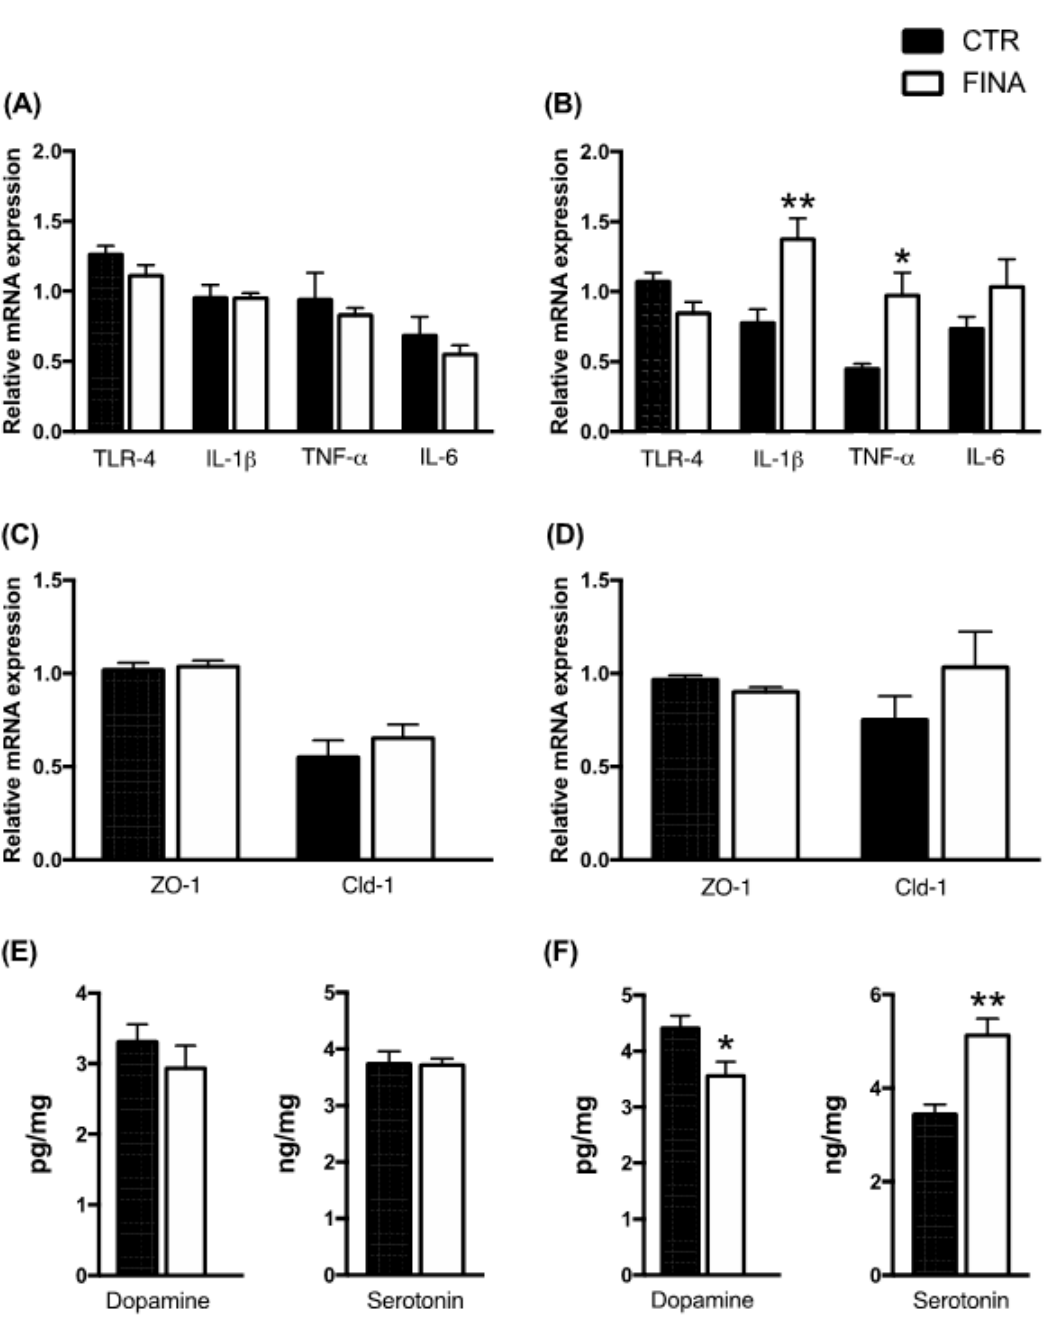
Figure 3. Gene expression of pro-inflammatory markers ( A , B ); gut permeability markers ( C , D ) detected by real-time PCR in colon of controls (CTR) and finasteride-treated rats (FINA) after drug treatment ( A , C ) and at withdrawal ( B , D ). The columns represent the mean ± SEM after normalization with 36B4 mRNA, n = 6 for each group. Levels of dopamine and serotonin ( E , F ) detected by LC- MS/MS in the colon of controls and finasteride-treated rats after drug treatment ( E ) and at withdrawal ( F ). Data are expressed in pg/mg or ng/mg ± SEM, n = 6 for each group. The unpaired Student’s t -test was used for statistical * p < 0.05, ** p < 0.01 vs. control